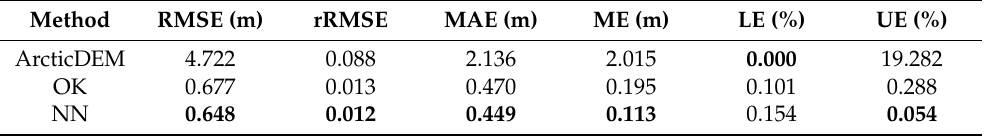
Table 3. Model evaluation metrics at Site-1. Areas outside the triangulation network were not evaluated for both ArcticDEM and the interpolated DTMs. Percentages of lower (LE) and upper (UE) extreme values were calculated in non-ground areas. Bold numbers indicate the best results.